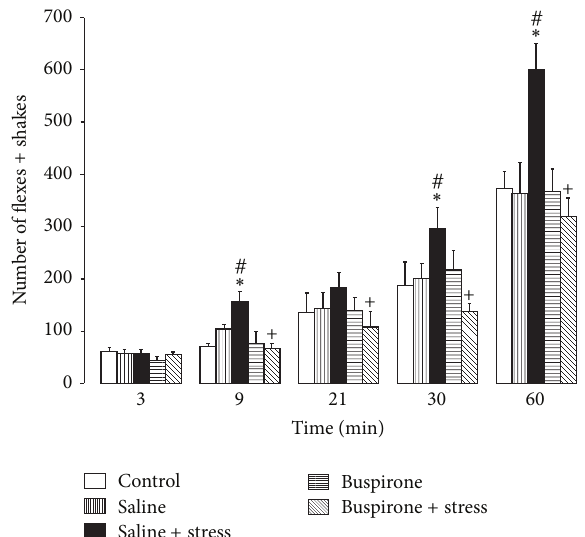
Figure1:Pain-likeresponsesrecordedoverdifferentperiodsoftime (3, 9, 21, 30, and 60min) after injection of formalin (mean ± SEM) in 7-day-old male rats with different prenatal treatments. ∗ P < 0.05 different from saline; + P < 0.05 different from saline + stress; # P < 0.05 different from controls.